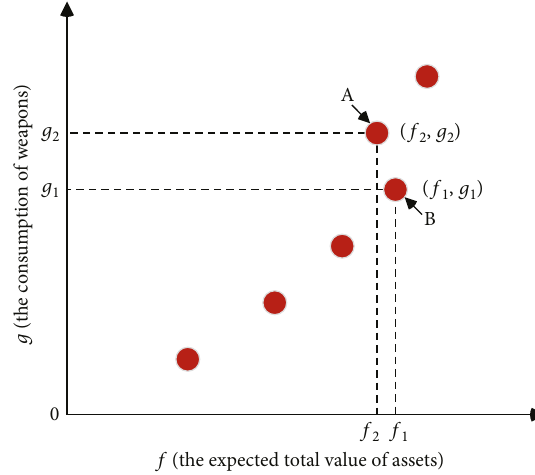
Figure 6: Illustration of the proposed mating